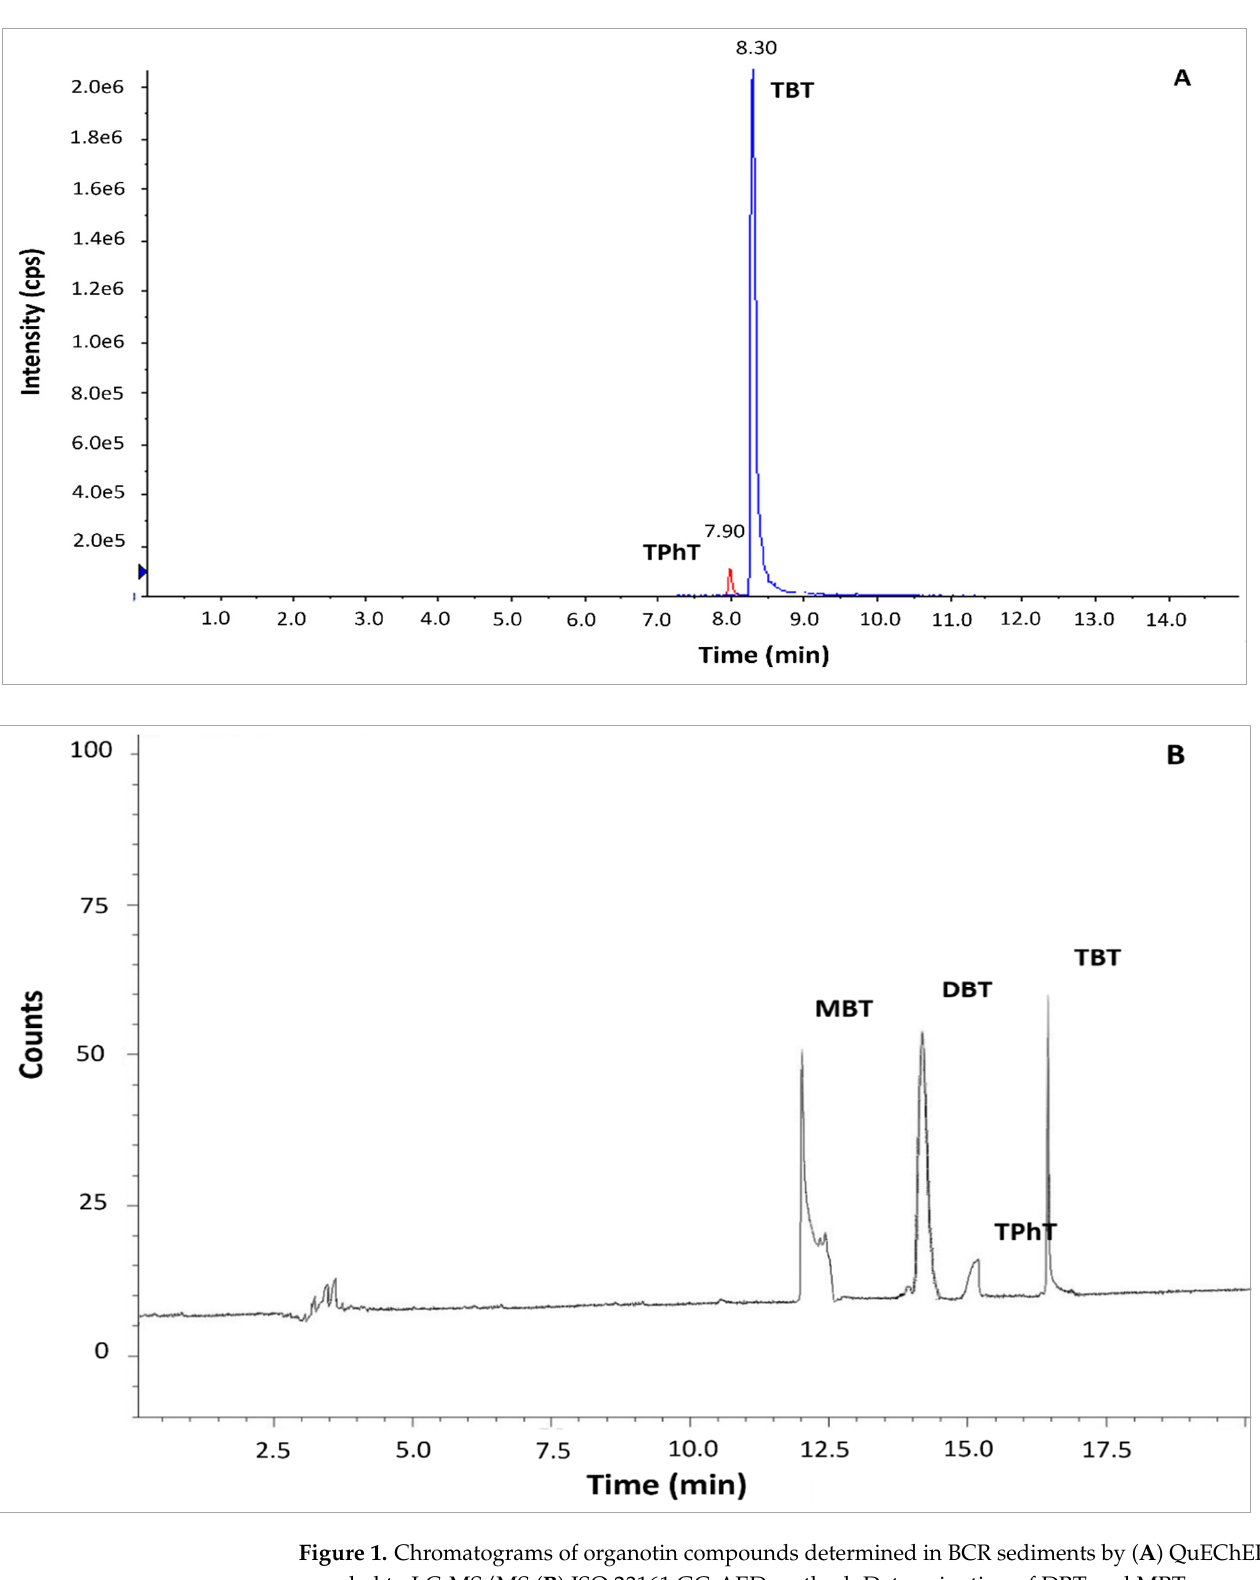
Figure 1. Chromatograms of organotin compounds determined in BCR sediments by ( A ) QuEChERS coupled to LC-MS/MS ( B ) ISO 23161 GC-AED method. Determination of DBT and coupled to LC-MS/MS ( B ) ISO 23161 GC-AED method. Determination of DBT and MBT was only MBT was only possible using the method ISO 23161 GC-AED. Abbreviations: MBT, monobutyltin; possible using the method ISO 23161 GC-AED. Abbreviations: MBT, monobutyltin; DBT, dibutyltin; DBT, dibutyltin; TBT, tributyltin; TPhT, triphenyltin. TBT, tributyltin; TPhT,